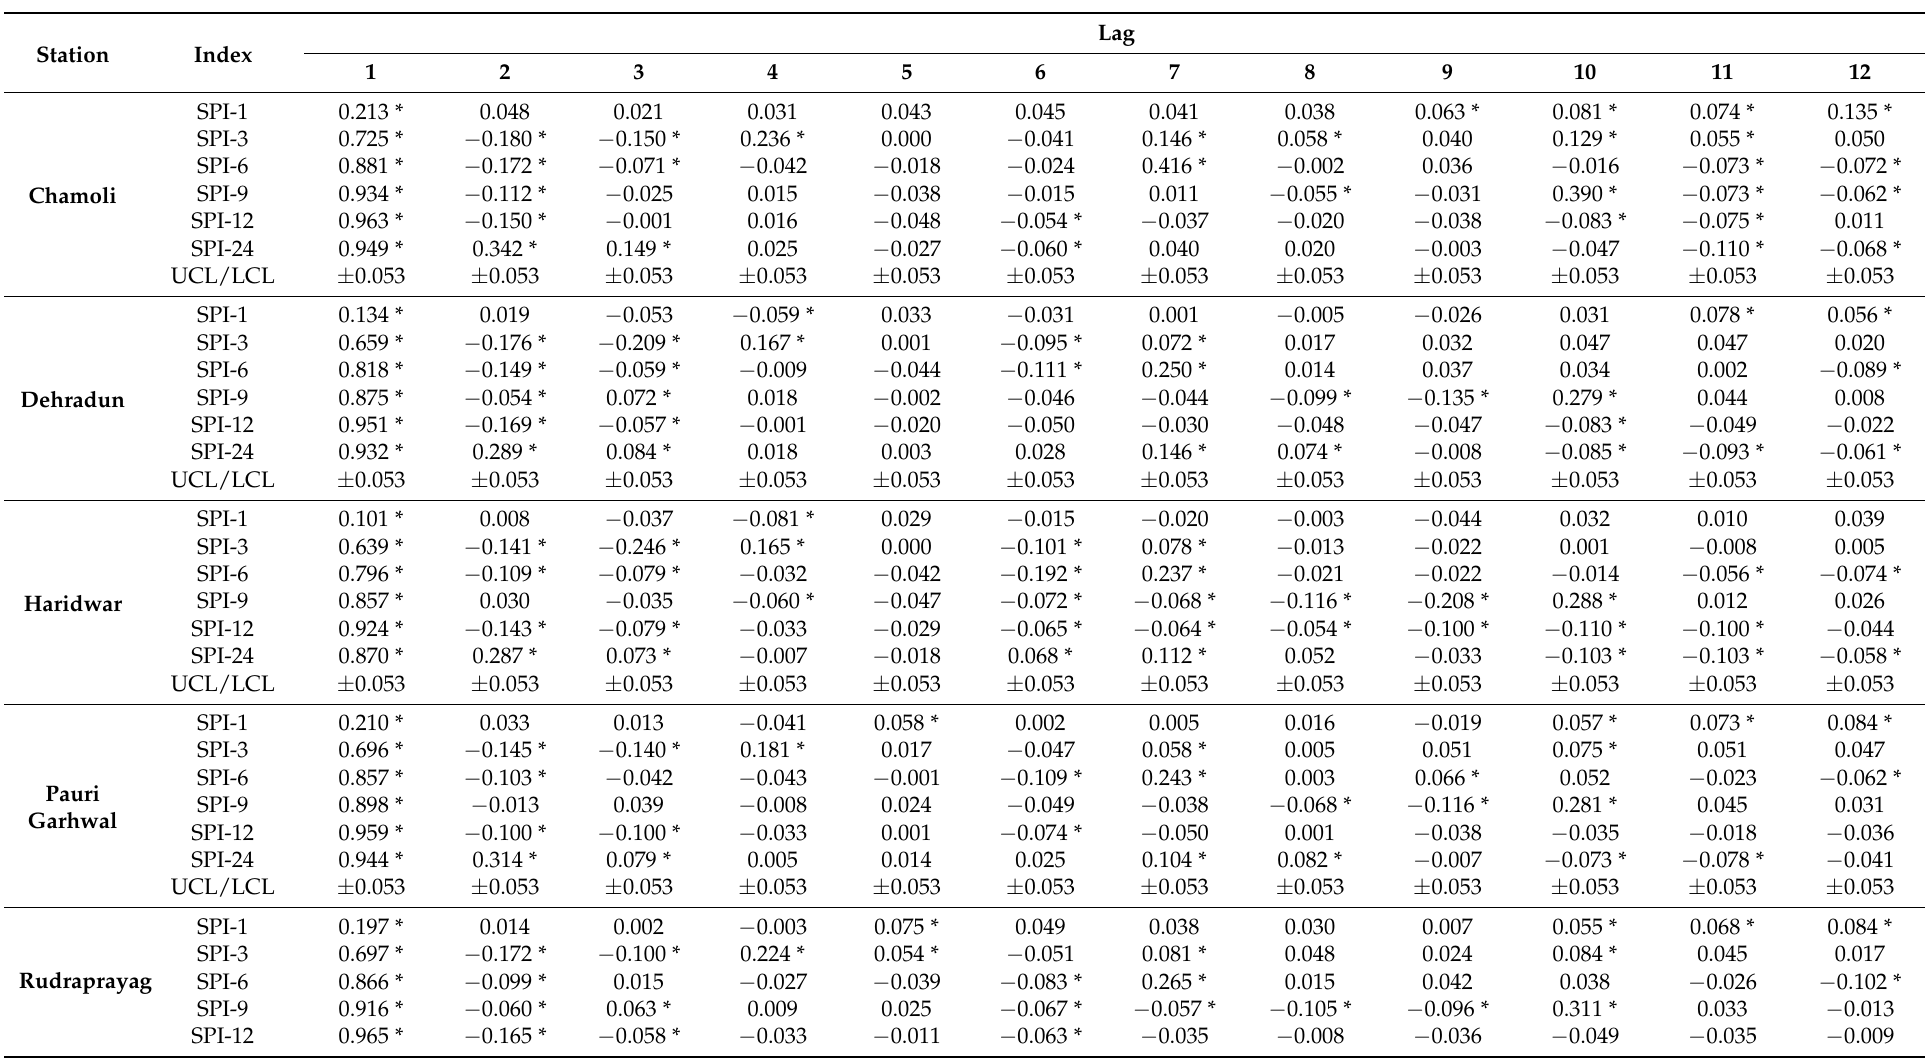
Table 2. The partial autocorrelation function (PACF) analysis of multi-scalar standardized precipitation index (SPI) at study